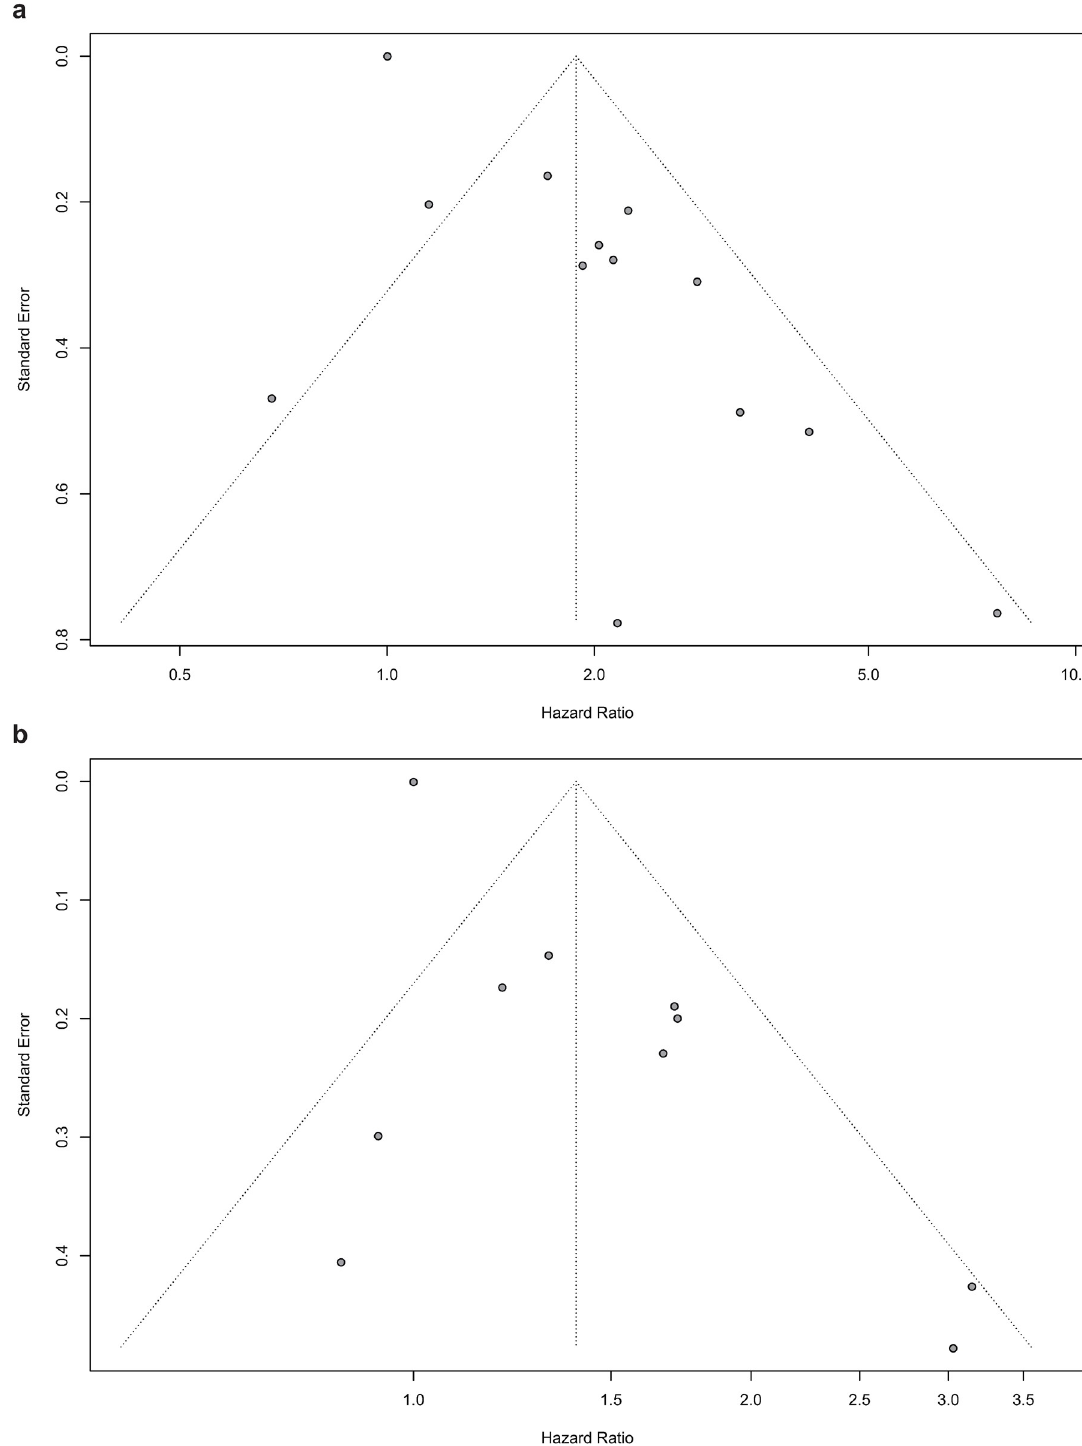
Fig 5. Funnel plots for detecting publication bias. a) funnel plot for OS; b) funnel plots for PFS.